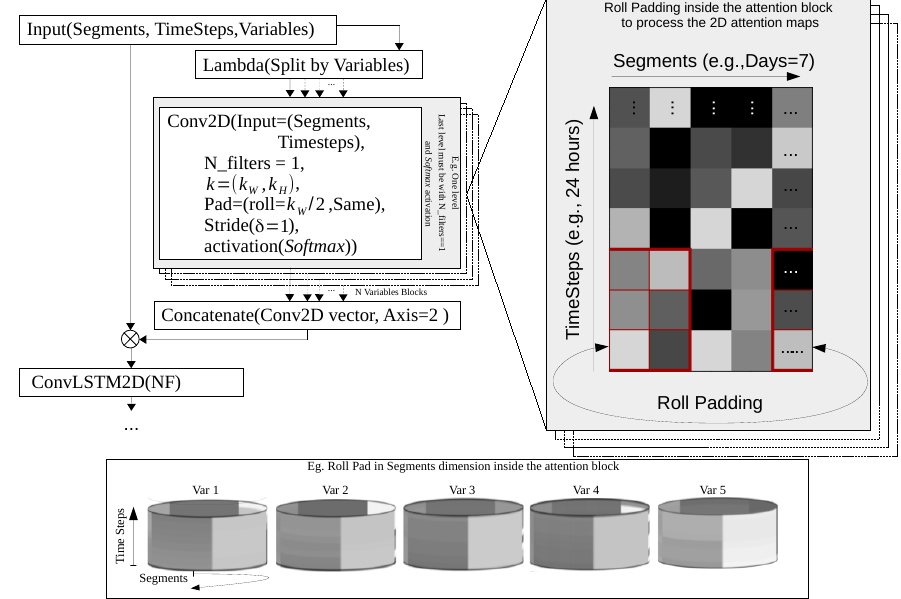
Figure 6. Attention using 2D convolutional layer before and after the